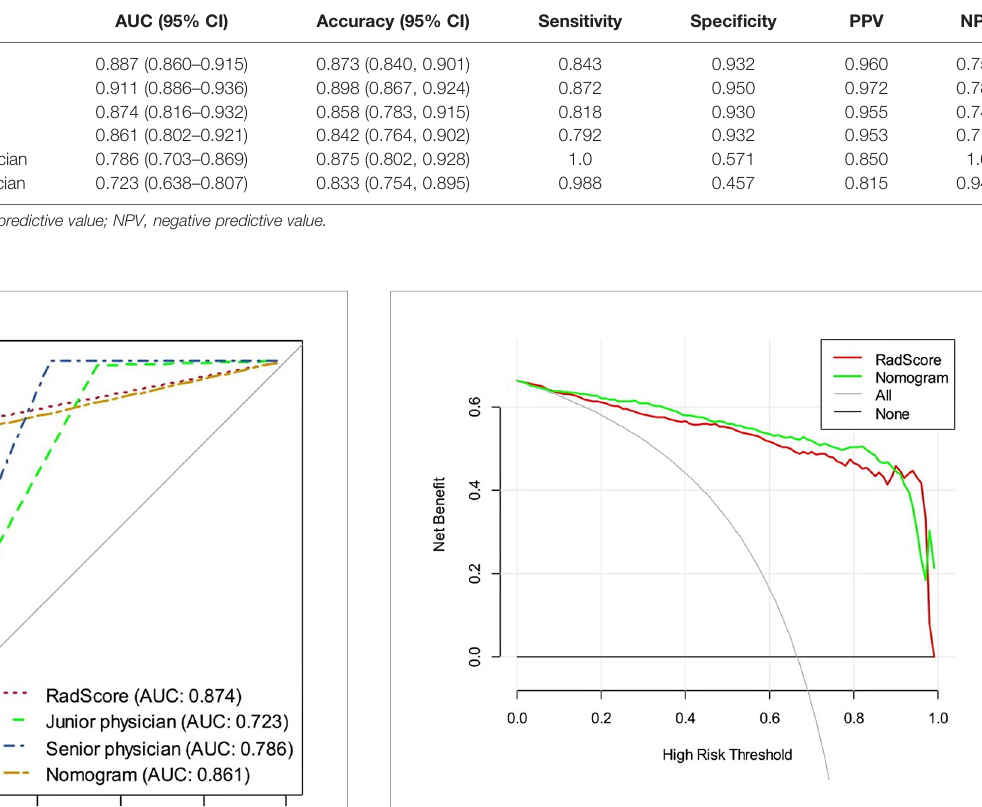
FIGURE 6 | Decision curve analysis for two models. The y -axis indicates the net bene fi t; the x -axis indicates threshold probability. The red line and green line represent net bene fi t of the radiomics signature and the radiomics nomogram,